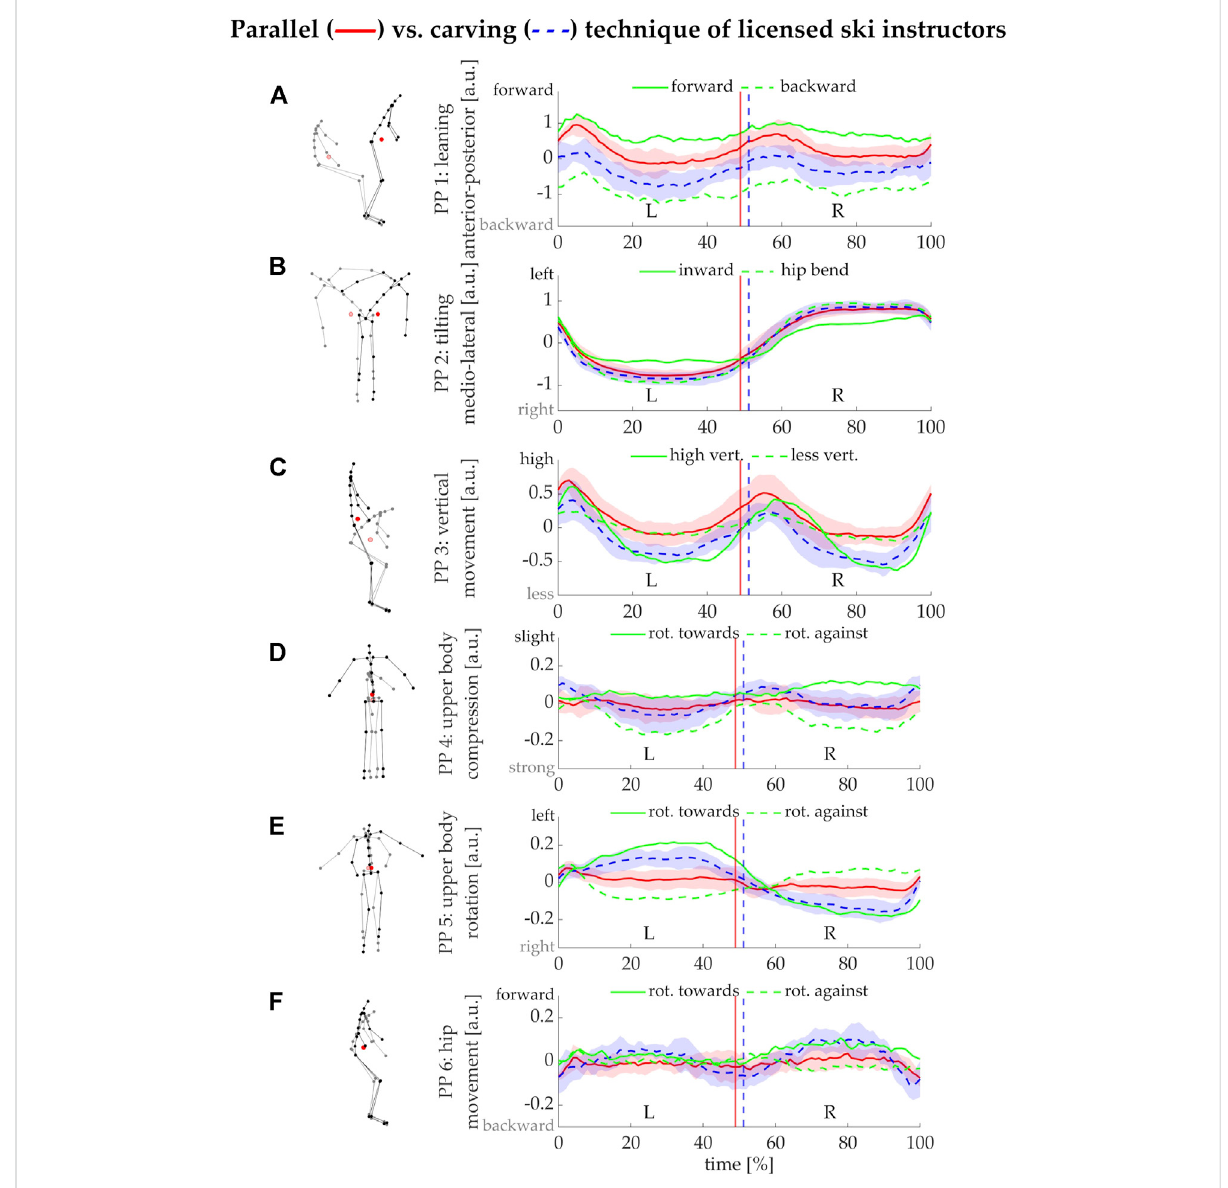
FIGURE 4 Left: stick fi gure representation of the fi rst six principal movements (PMs). Right: time series representation for each principal movement position PPk(t) [k = 1.6] (A – F) interpolated to 100% of a left(L)-right(R) ski turn cycle. For each PM, the instruction trials that caused the largest differencesin thePP(t) — e.g., for PM1theinstructions to leanforwardor backward — are displayed as continuous and broken green lines (means over all turn cycles of all volunteers).The red and blue lines and shaded areas represent the mean and standard deviations obtained from theparallel and carving turns of all the volunteers, respectively. Vertical lines indicate the mean time point of transition from L to R